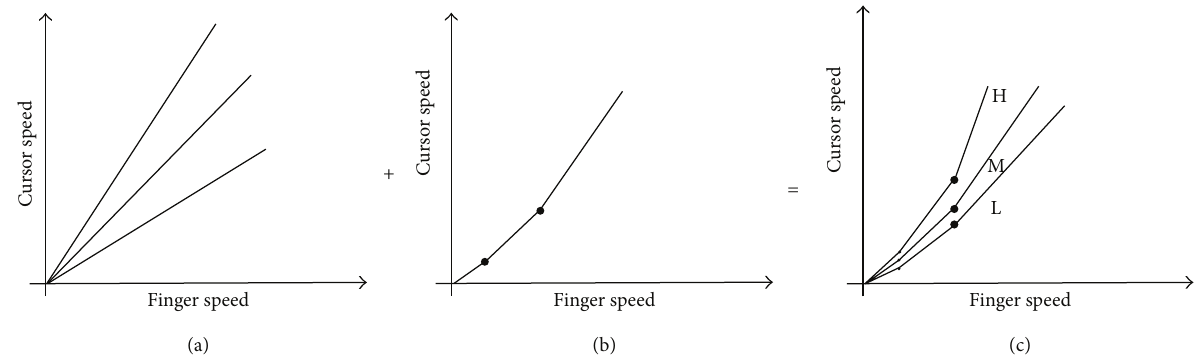
Figure 3: The LMH interaction technique (c) combines the advantages of explicit (a) granularity switching with the benefits of implicit accelerated (b) mice and